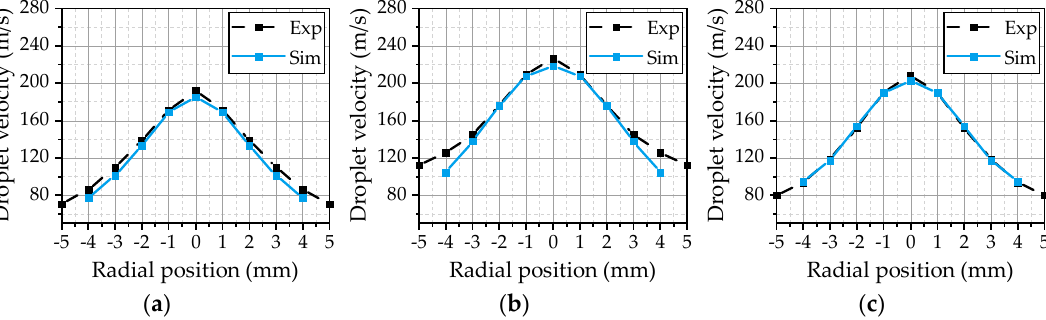
Figure 9. Simulated and measured radial velocity profiles of droplets with a diameter of 8 μ m for OP 1 ( a ), OP 2 ( b ) and OP 3 ( c ).